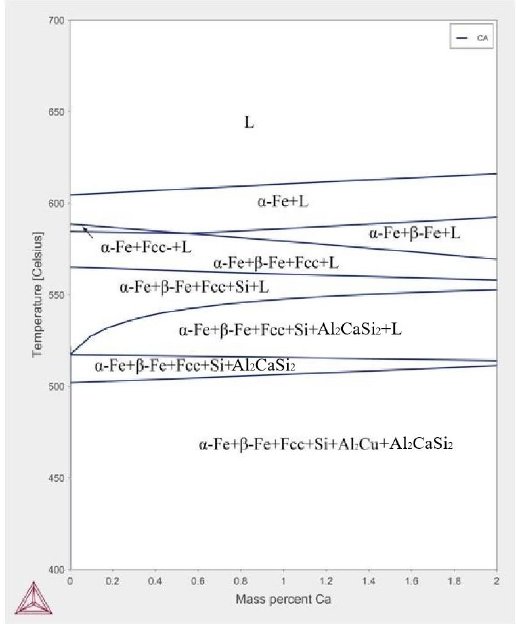
Figure 1. Al-Si-Cu-xCa phase diagram (Si = 9%, Cu = 3.5%, Mn = 0.4%, Fe = 1%, Mg = 0.2%,